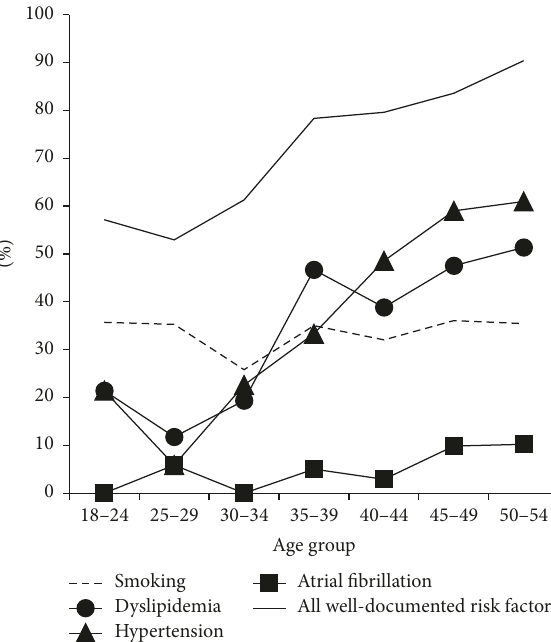
Table 2: Sources of cardioembolism in first-ever stroke patients.